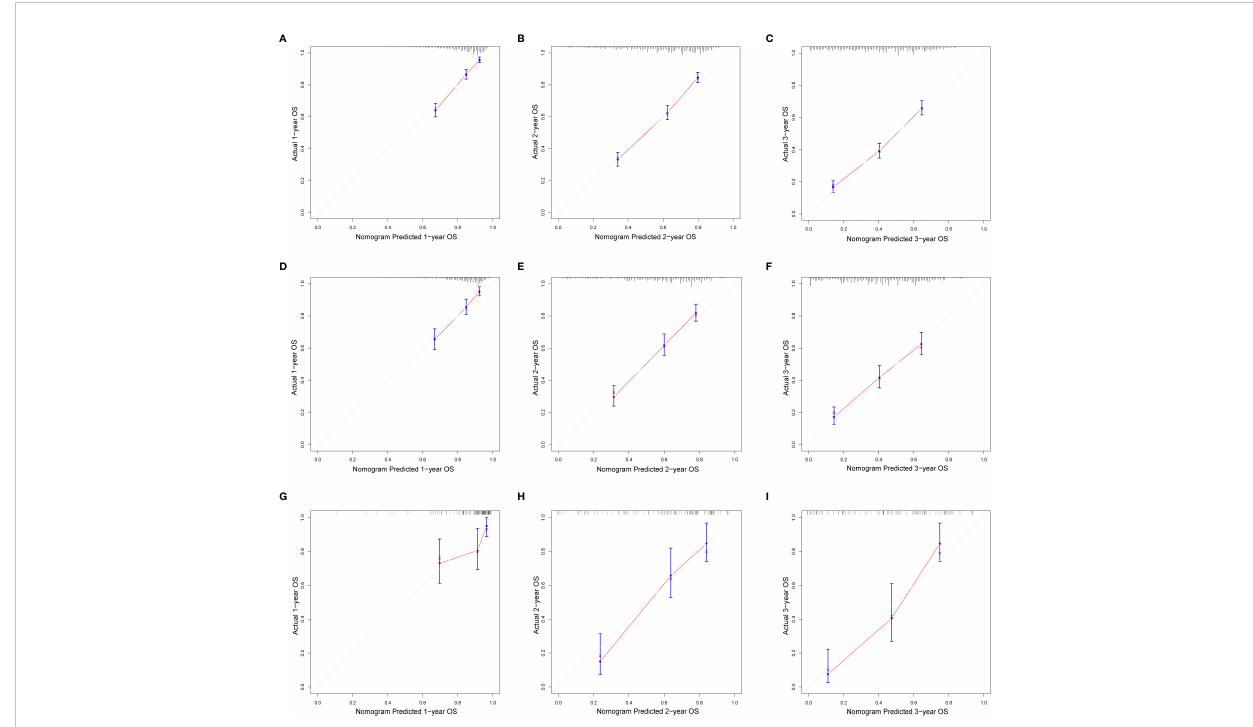
FIGURE 4 The calibration of nomograms to predict 1-, 2-, and 3-year overall survival in the training cohort (A – C) , validation cohort (D – F) , and testing cohort (G – I) .